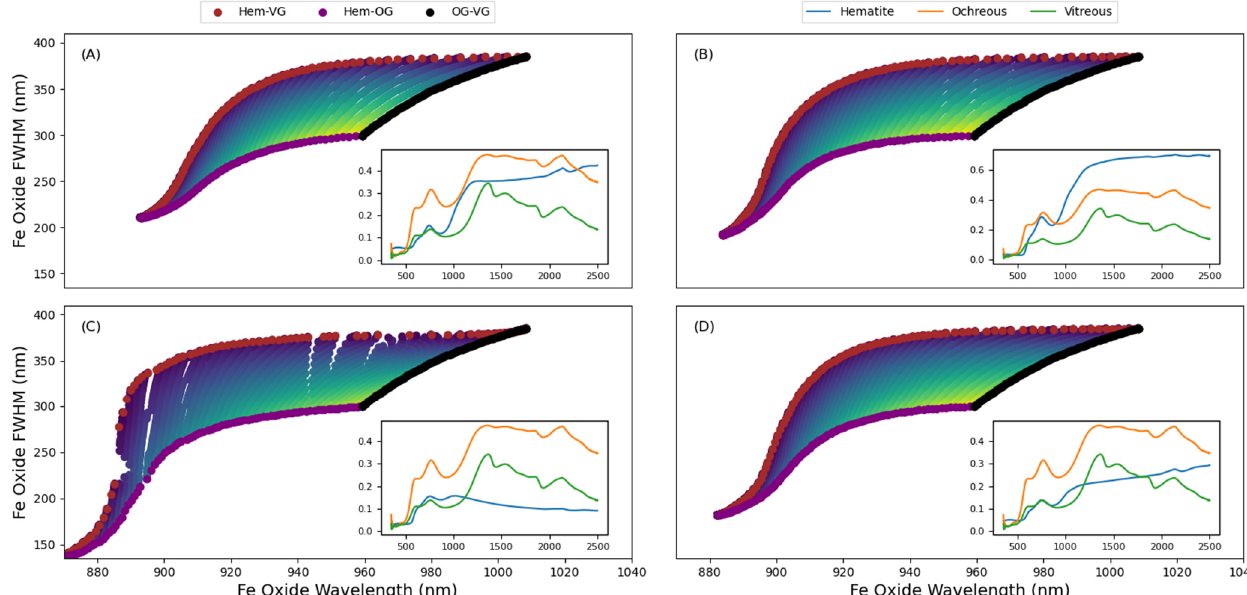
Figure 6. The effect of the hematite endmember on the iron boomerang. Each plot is the iron boomerang manifold for the 3 spectral endmembers shown in the respective inset reflectance plot. The only variable in figures ( A – D ) is the hematite endmember. The upper-edge of the boomerang corresponding to a 2-mixture state of hematite and vitreous goethite (Hem-VG) while the lower-edge is a 2-mixture state of hematite and ochreous goethite (Hem-OG). The interior of the boomerang are 3-mixture states of the hematite, ochreous, and vitreous endmembers and are coloured by the percentage of vitreous goethite in the mixture. Note the void in ( C ) around an Fe Oxide Wavelength of 970 nm and Fe Oxide FWHM of 370 nm is a product of the linear mixing. The hematite endmembers are ( A ) martite, ( B ) hematite (Bayer 160), ( C ) hematite − 95%–magnetite − 5%, and ( D ) microplaty– hematite.